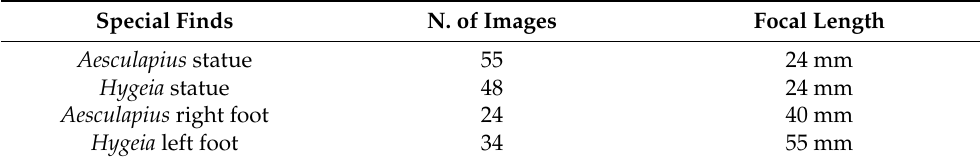
Table 1. Details of the photogrammetric survey of the Special Finds. Special Finds N. of Images